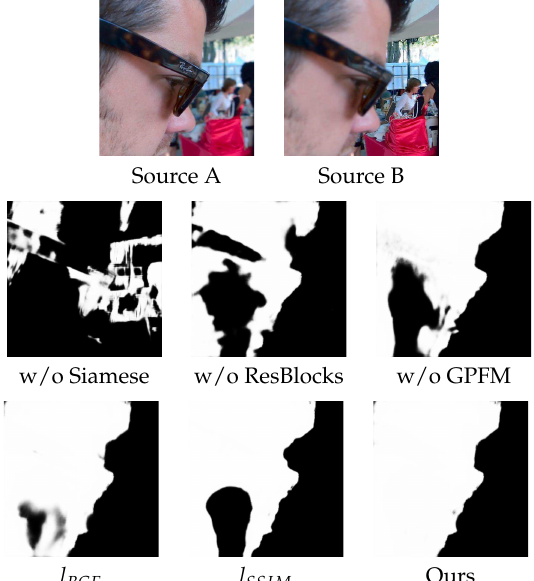
Figure 14. Decision maps generated by different architectures and loss functions. Here, w/o Siamese, w/o ResBlocks and w/o GPFM denote that the Siamese encoder, ResBlocks and the global perception fusion module are removed from the fully implemented network respectively, then train it with the hybrid loss function. l BCE and l SSIM denote that the fully implemented network is trained with the BCE loss and the SSIM loss,